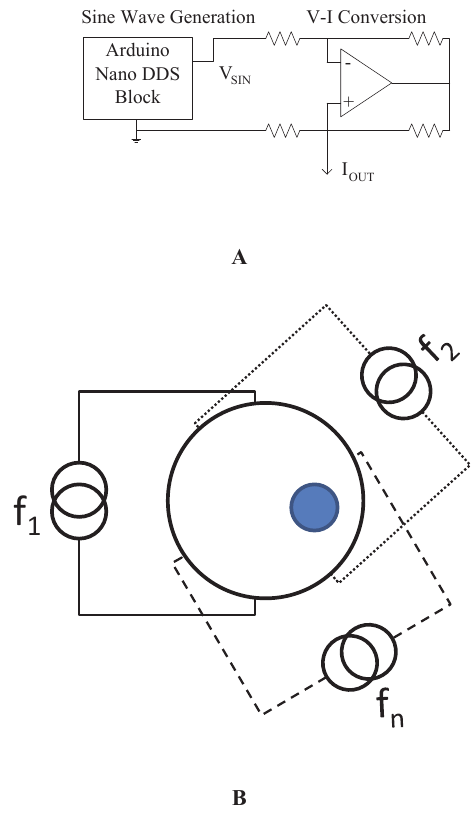
Fig. 1: A - Current source implementation. Sine wave generation performed by Arduino Nano with output filtering. Howland current pump used for V-I conversion. B – Example connection of multiple current sources to